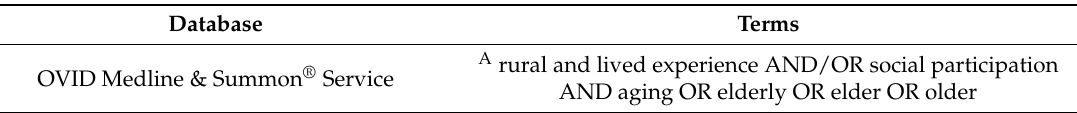
Table 1. Search terms used to identify social participation among rural older